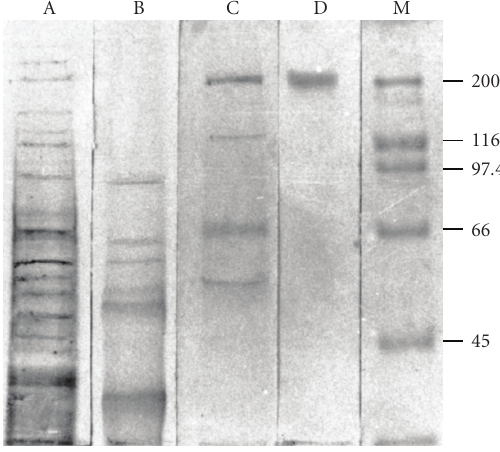
Figure 4: Purification of cysteine protease and metalloprotease from Cryptobia salmositica . Lane A: crude cell lysate; lane B: partially purified cysteine protease from a DEAE-agarose column; lane C: partially purified metalloprotease from a DEAE-agarose column; lane D: a single band of purified metalloprotease from a Sephacryl S-300 column; lane M: molecular markers (kDa) (reproduced from Zuo & Woo [18]).